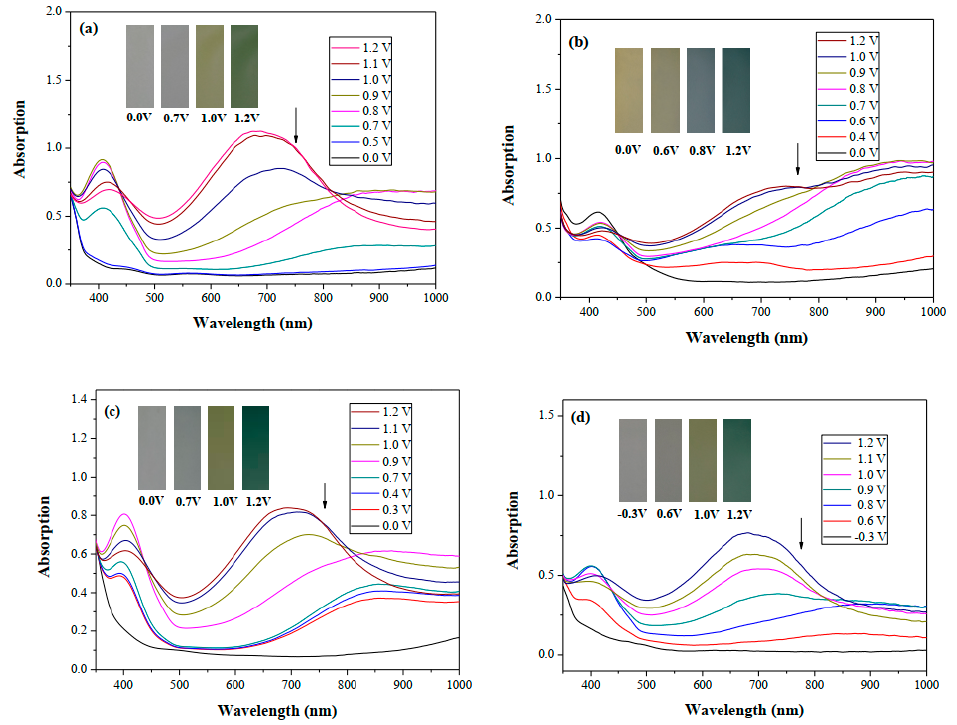
Figure 6. UV–Vis spectra of ( a ) PbCmB, ( b ) P(bCmB- co -bTP), ( c ) P(bCmB- co -dbBT), and ( d ) P(bCmB- co -TF) in an ACN/DCM (1:1 by volume) solution containing 0.2 M LiClO 4 . Table 2. Colorimetric values (L*, a*, and b*), CIE chromaticity values ( x , y ), and diagrams of ( a